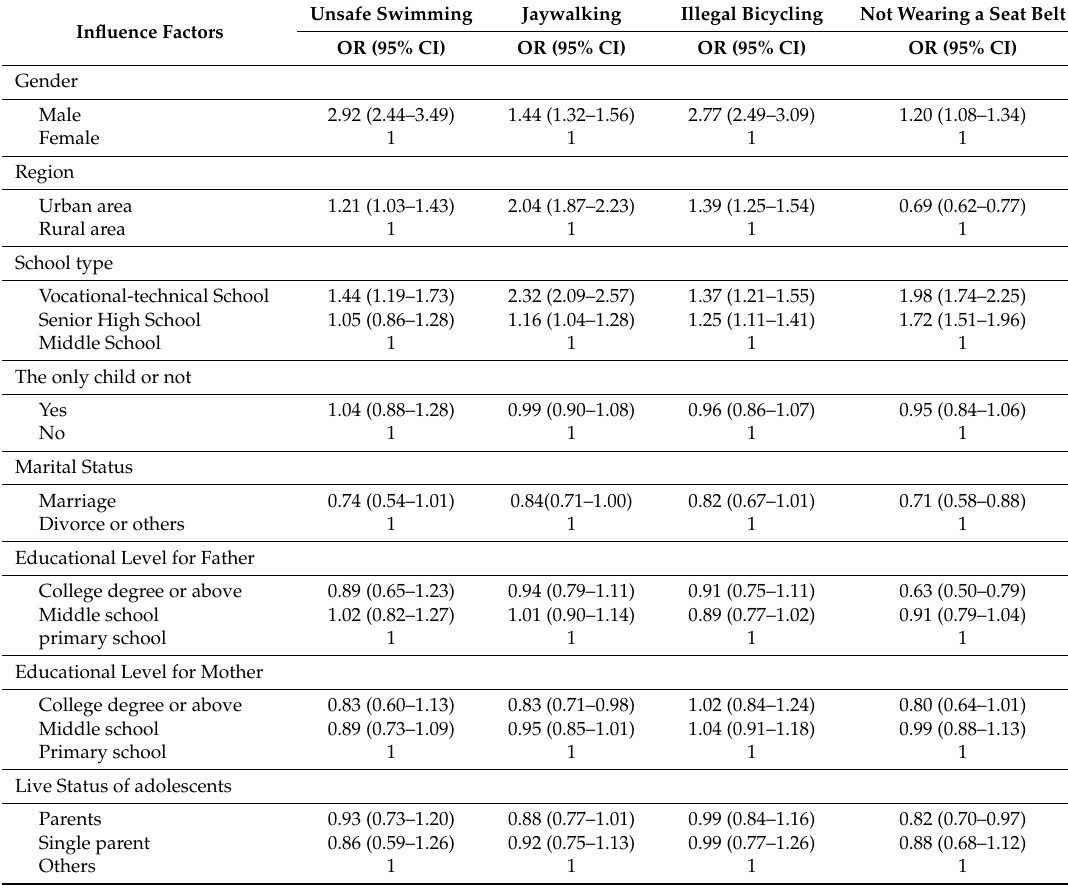
Table 4. Identification of the possible influential factors leading to the four unintentional injury-related behaviours by multiple logistic regression